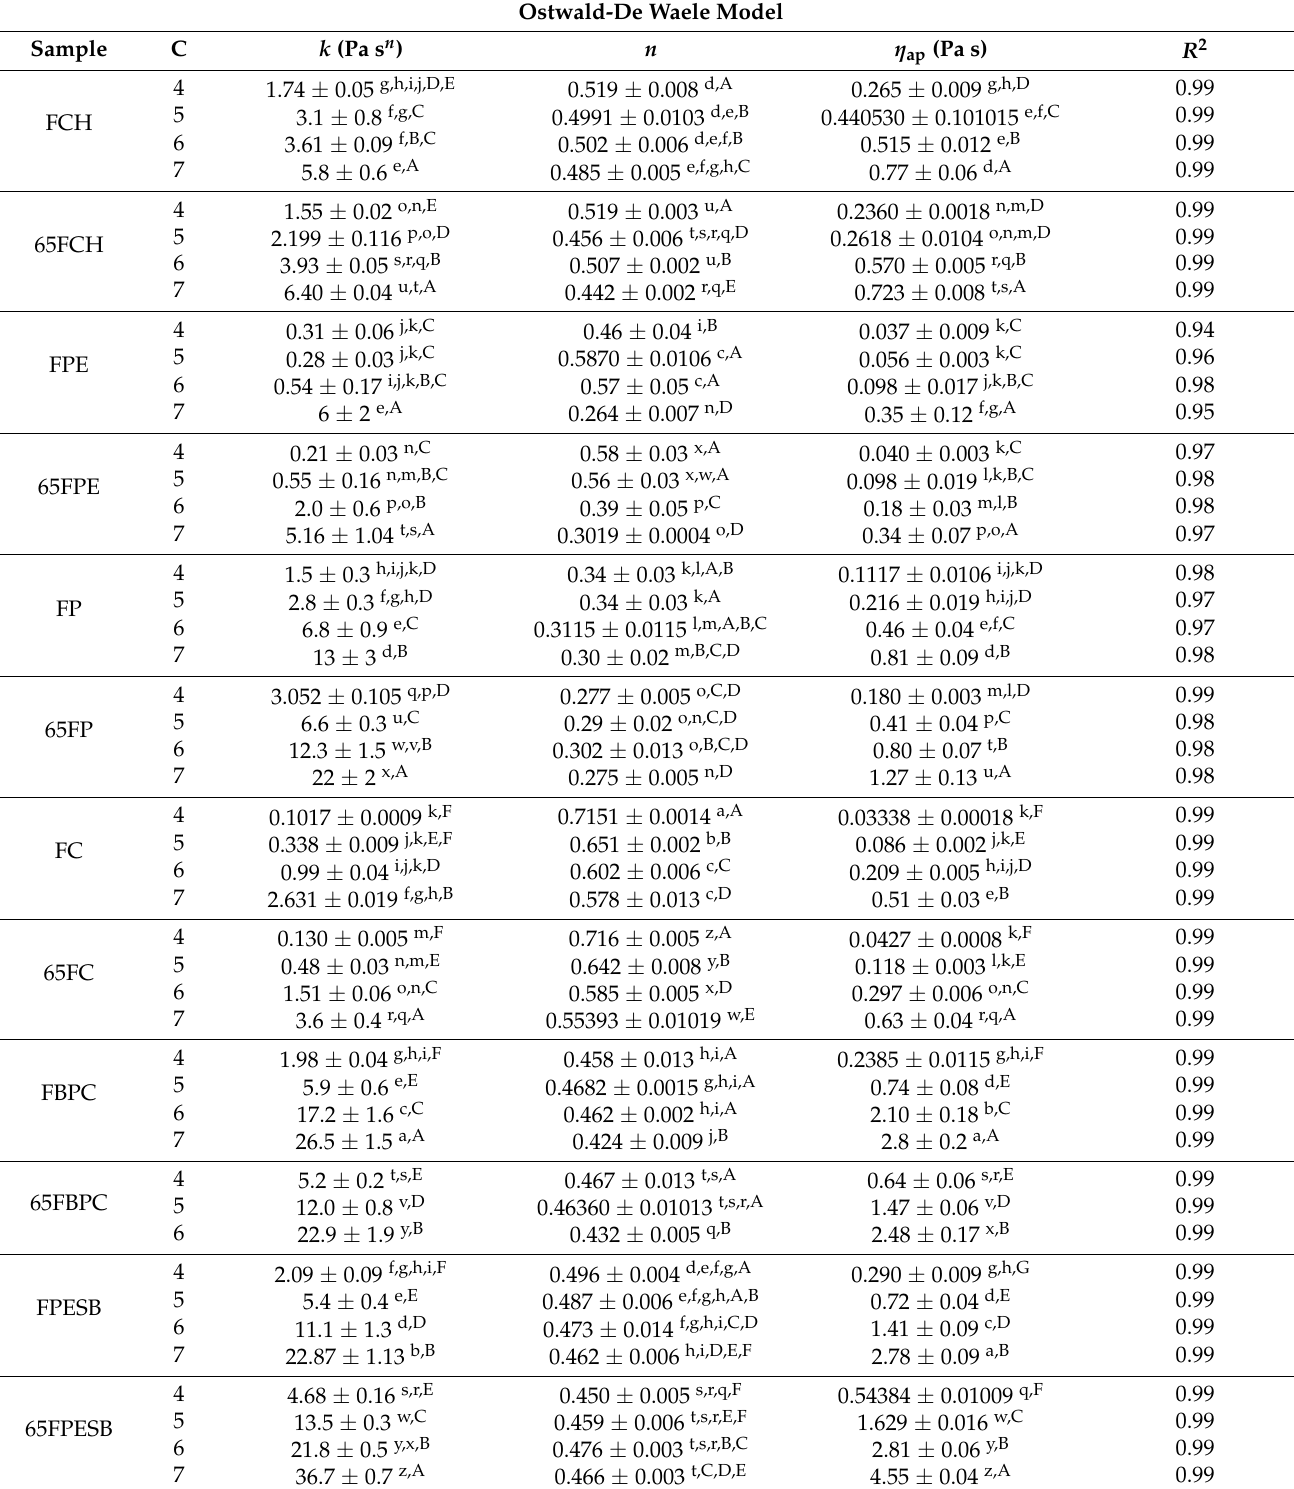
Table 6. Mean values ± standard deviations of the rheology parameters k (consistency index), n (flow index) and η ap (shear viscosity at 50 s − 1 shear stress) of the formulated